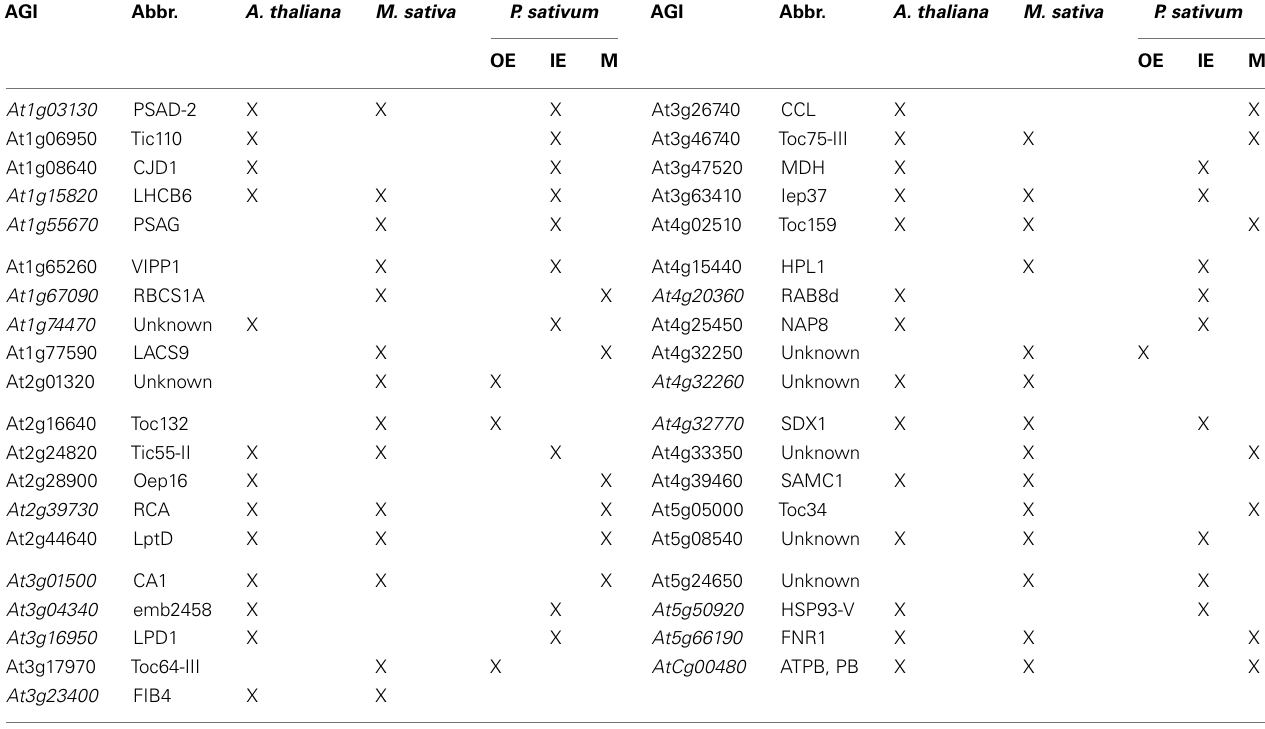
Table 2 | Proteins in the envelope fraction of at least two